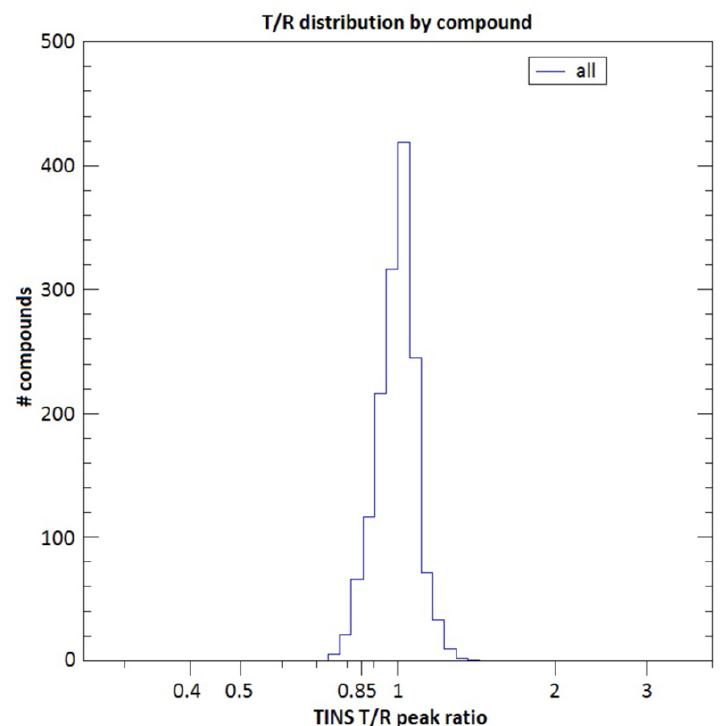
Figure 2. TINS profile of the screening. The TINS profile shows the compounds from the ZoBio fragment library binding to immobilized FtsQ p (target) vs. Akt-PH (reference).